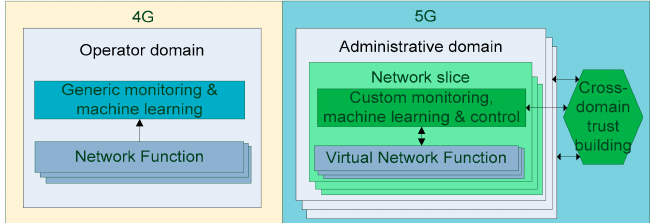
Figure 1. Evolution of security monitoring from fourth generation (4G) to fifth generation (5G) of mobile networks. The foci of our investigation—software-defined and big data analytic means to customize monitoring, machine learning, and control of virtualized 5G networks as well as means to share trust-relevant knowledge across domains—are highlighted in